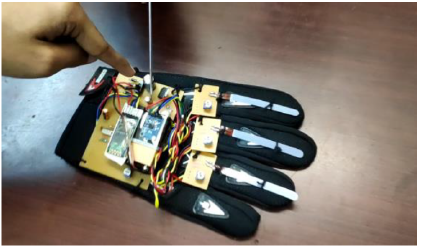
Figure 3: Hardware setup of the Proposed